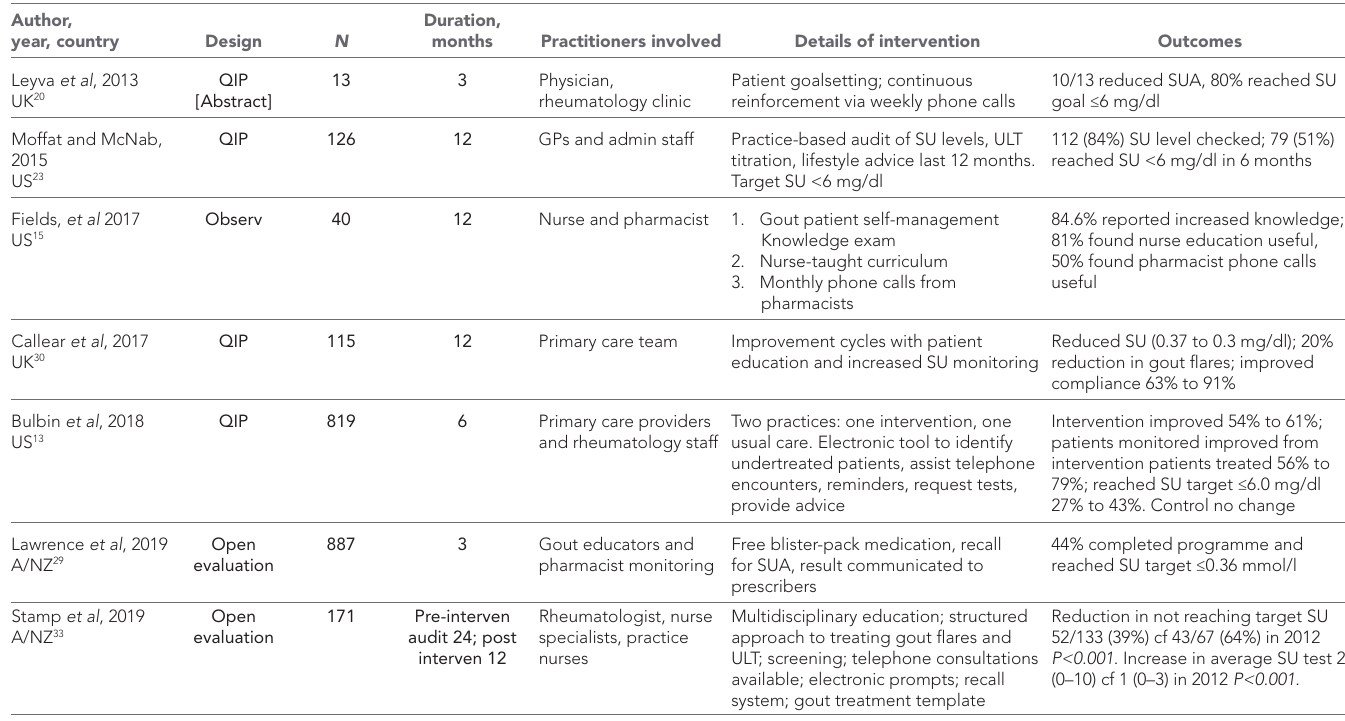
Table 3 Characteristics of included studies on other